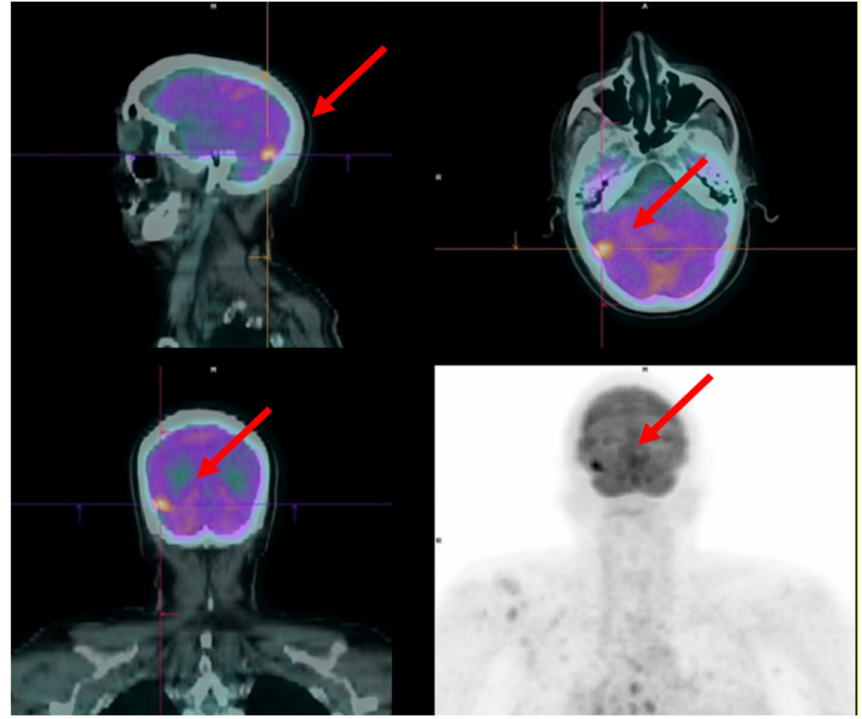
Figure 5. Brain metastasis in the right temporo-basal cortex (red arrows) incidentally discovered by 18F-FDG PET in an mCRPC patient candidate to the Ra-223